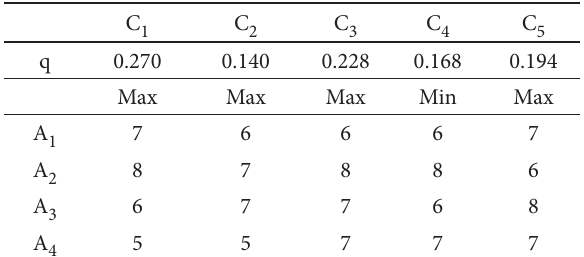
Table 4. Decision making matrix